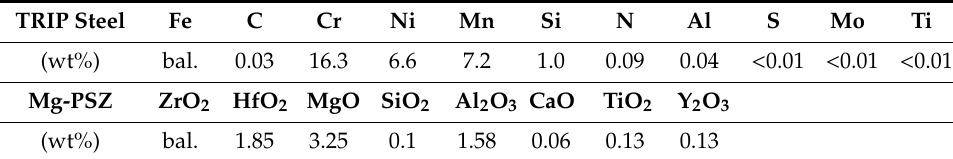
Table 1. Nominal chemical compositions of TRIP steel and Mg-PSZ